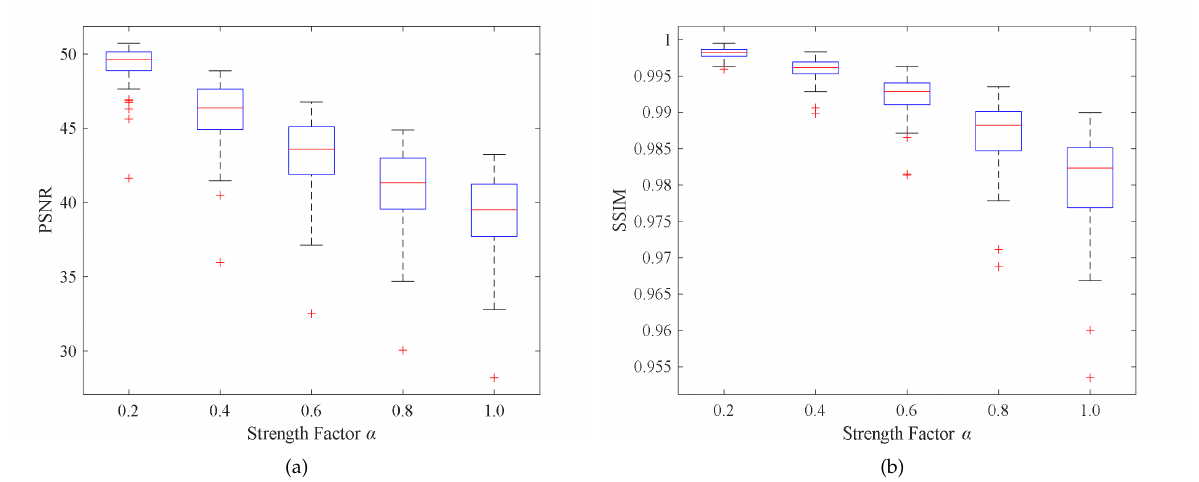
Figure 7. Boxplots for quality evaluation of watermarked images generated under different strength factors α : ( a ) PSNR and ( b )